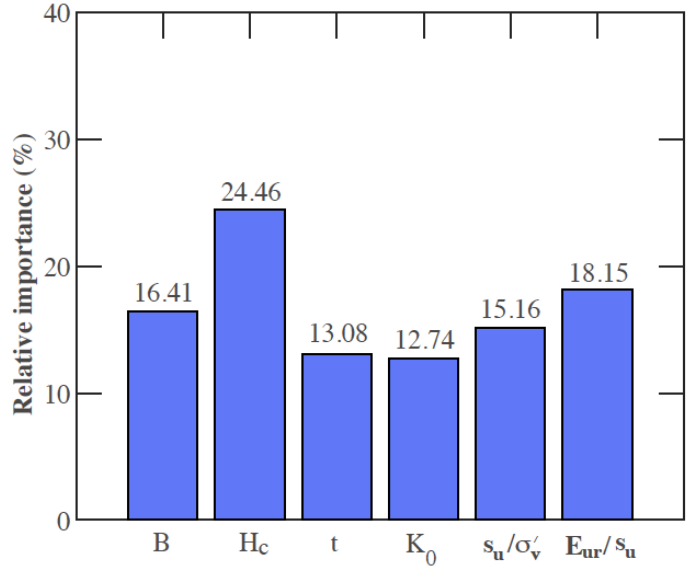
Figure 16. Sensitivity analysis of input parameters.